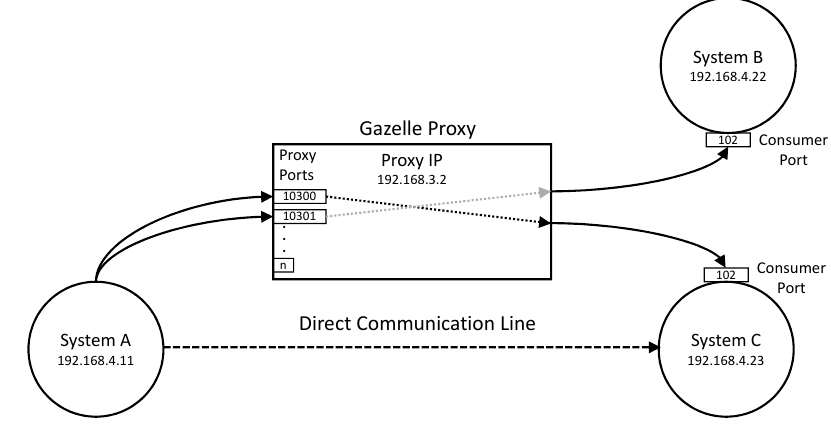
Figure 17. Derailing communication via Gazelle proxy service: port numbers are assigned to the systems prior testing, transferred messages are captured to undergo